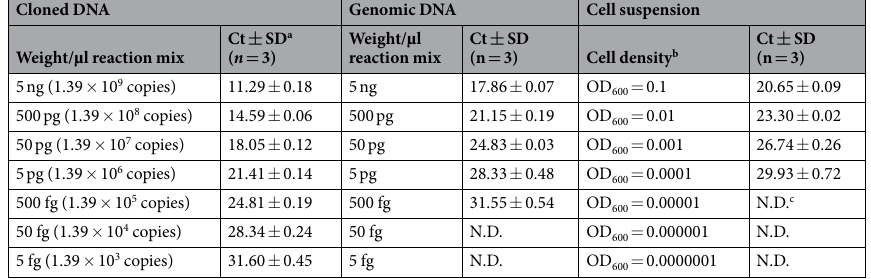
Table 5. Mean cycle threshold (CT) end-point fluorescence of 10-fold serial dilutions of Bacillus subtilis subsp. subtilis LMG 7135 cloned DNA, genomic DNA and a cell suspension determined with real-time PCR assay. a SD, Three reactions standard deviation. b OD = 600 nm. c N.D., Not